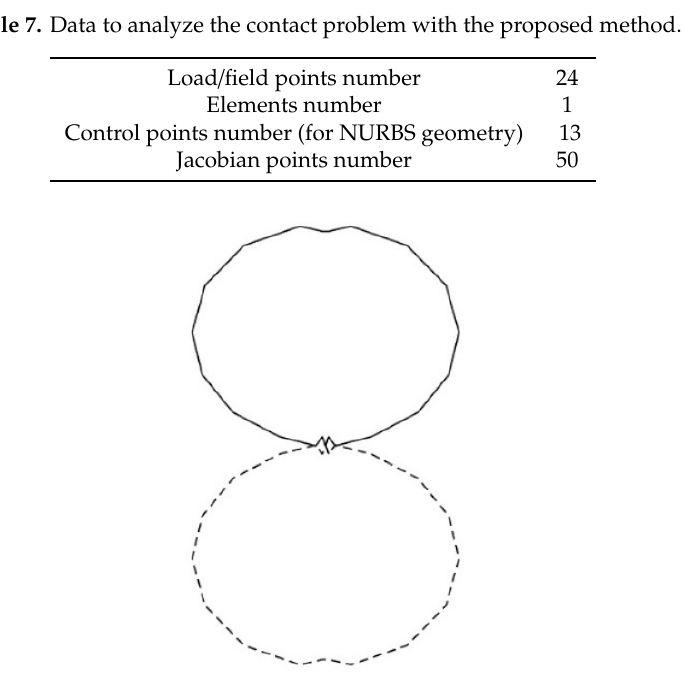
Figure 15. Contact between two bodies analyzed with proposed IGA-BEM.